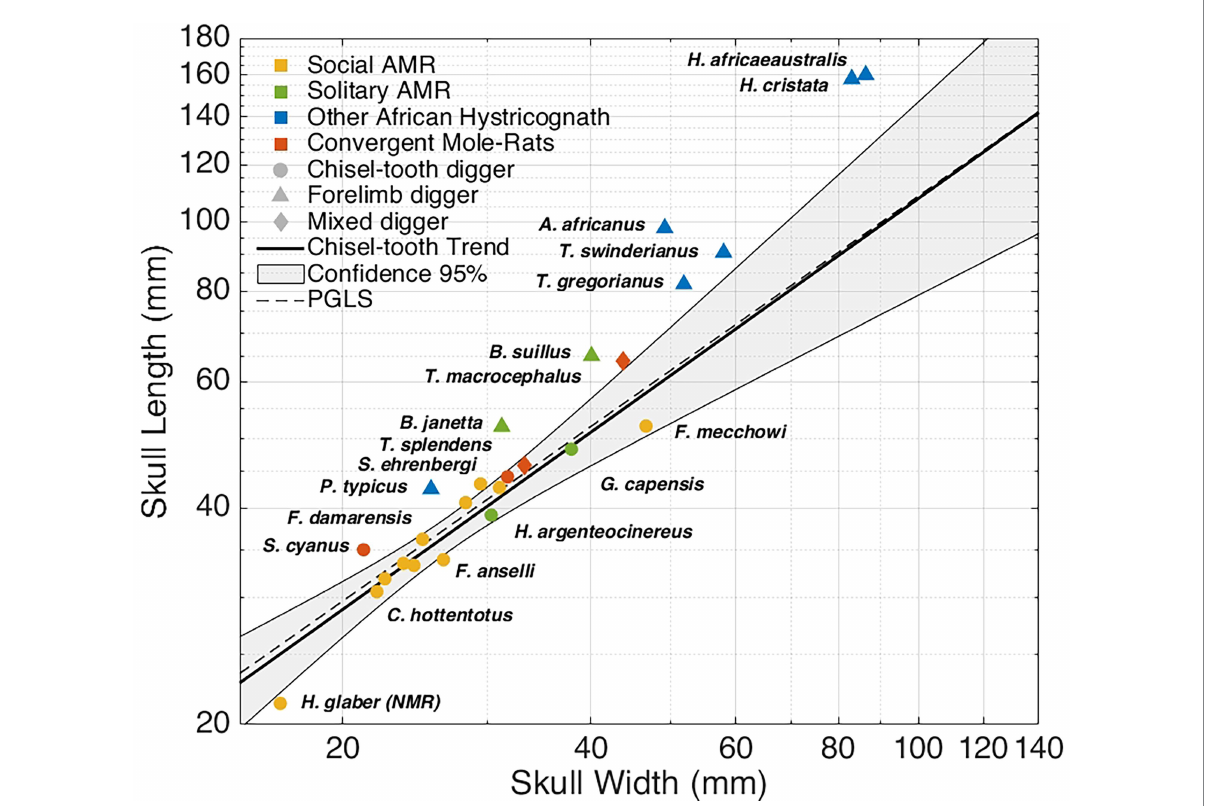
FIGURE 1 Relation between the length and width of the skull in African mole rats, their closes relatives, and convergent subterranean rodents. Chisel-tooth digging subterranean rodents present a smaller skull length/width ratio than forelimb diggers. The naked mole-rat ( Heterocephalus glaber , NMR) has a significantly shorter snout even when compared to other chisel-tooth digging African mole-rats. Each data point is coloured according to its social or phylogenetic attributes as indicated in the figure. The shape represents digging mode. The linear regression line for chisel-tooth diggers with 95% confidence intervals is shown, together with the regression line based on phylogenetic generalized least squares (PGLS). All data was retrieved from Kingdon (2014) See Materials and methods in the SM for more details. PGLS was calculated using the evolutionary tree in Supplementary Figure